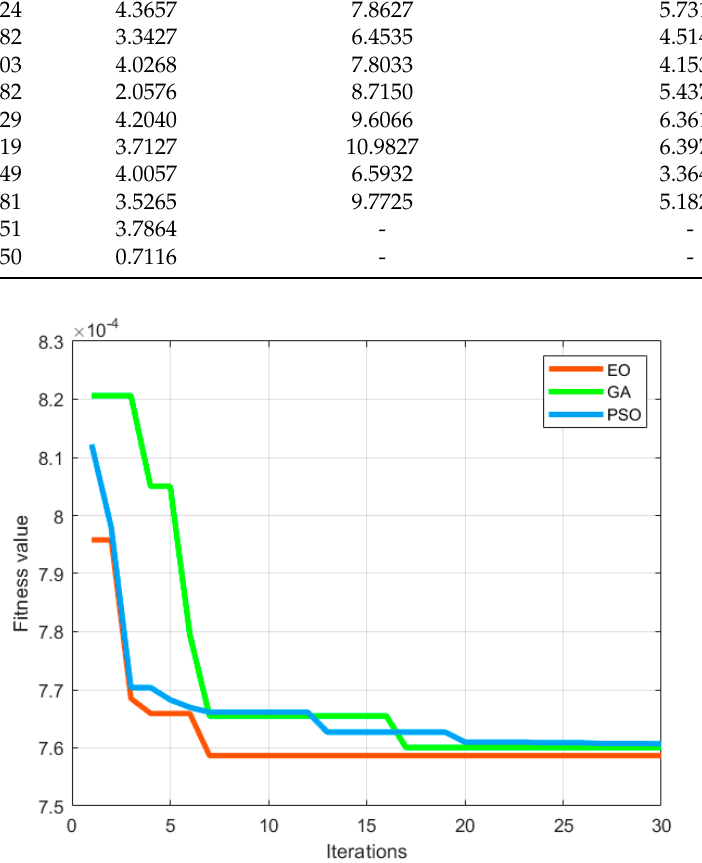
Figure 6. Comparison of fitness curves from the optimization of parameters for transfer function with single vibration compensation.